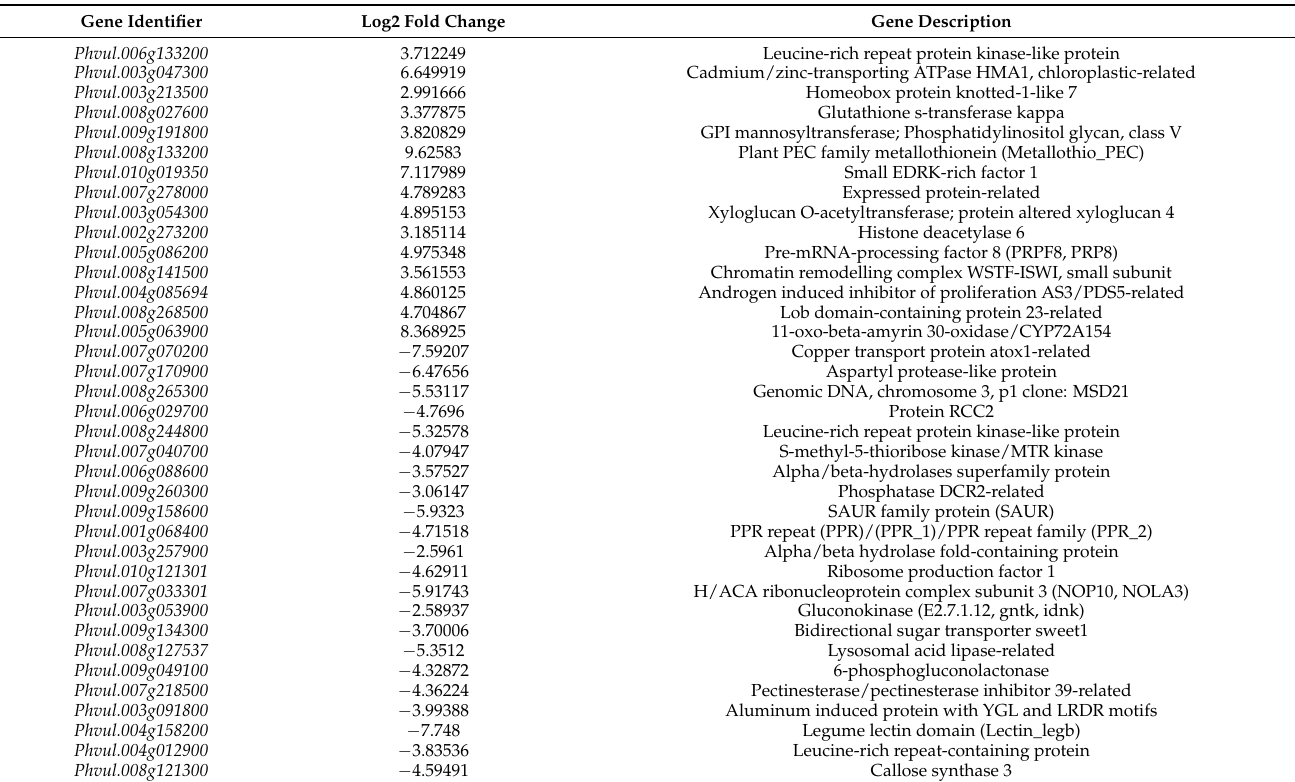
Table 2. Description of top 50 DEGs with a distinct expression pattern in the slow-cooking (Pinto) and fast-cooking (Rosecoco) bean